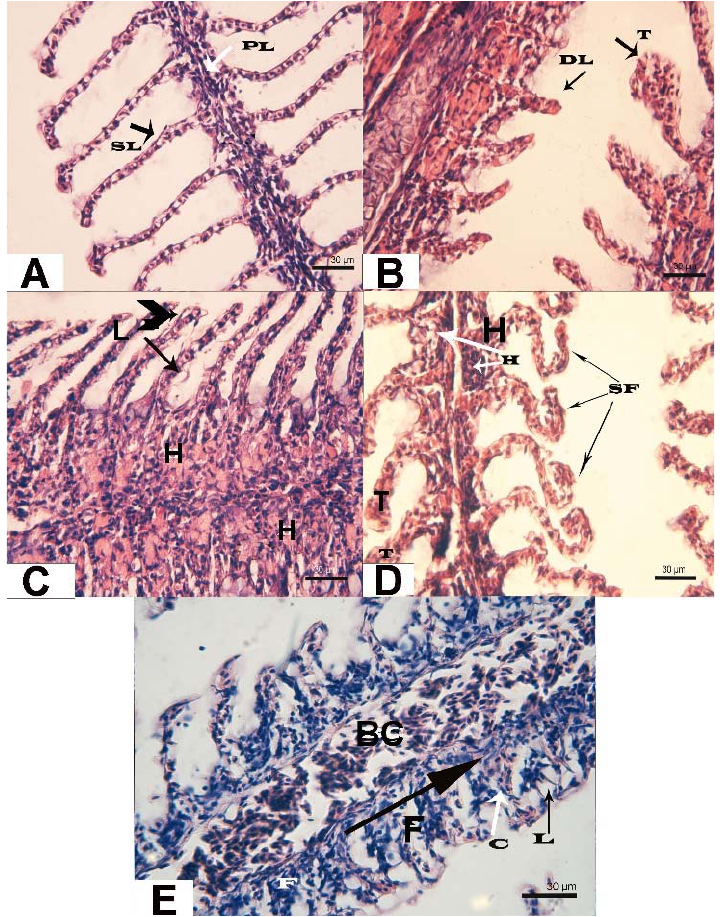
Fig. 2: Micrographs of the gill of Caspian roach (Stained by Hematoxilin and Eosin) [A] Normal image of the gill, primary lamellae (PL), Secondary lamellae